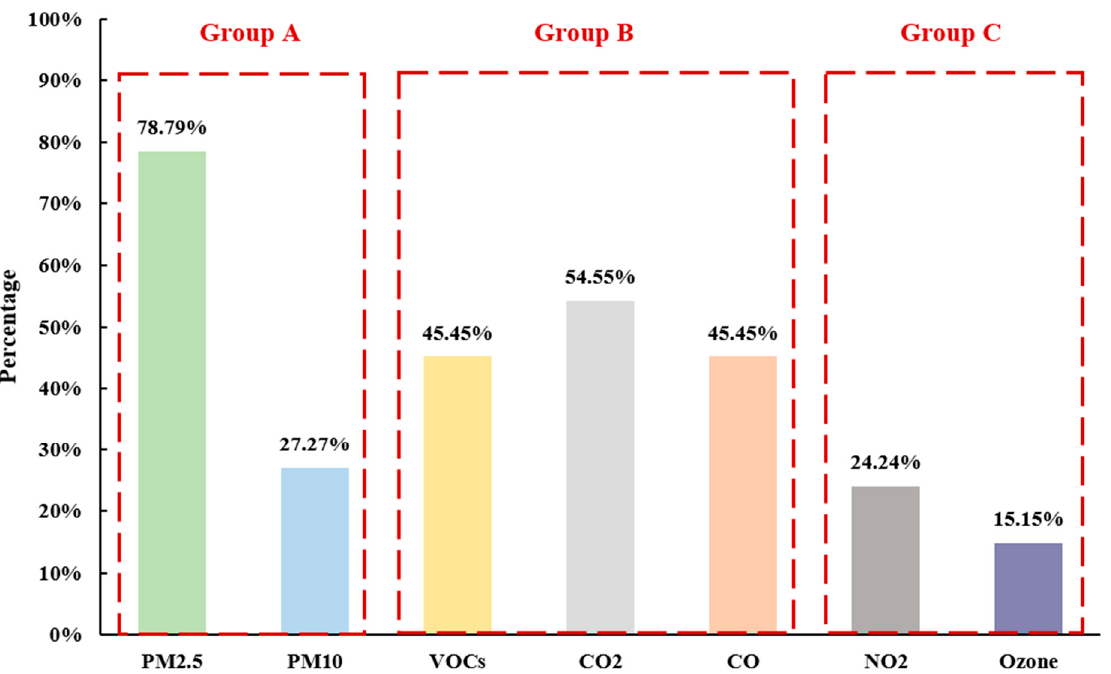
Figure 5. Distribution of the tested IAQ factors. Note: CO2 and CO 2 , PM2.5 and PM 2.5 , PM10 and PM 10 , and NO2 and NO 2 are used interchangeably.